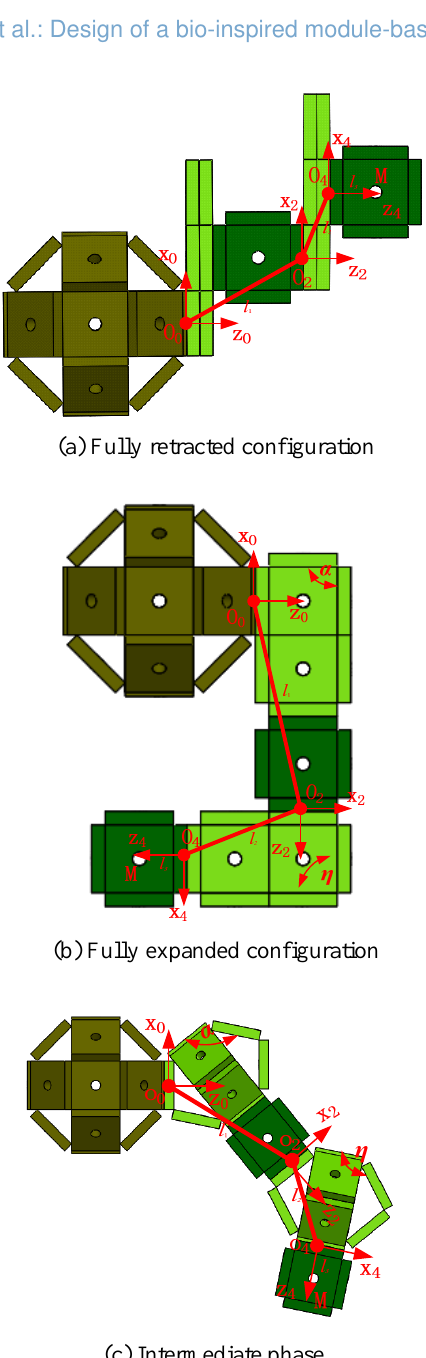
Based on the changes of the lengths of the three equivalent links l 1 , l 2 and l 3 , the workspace augmentation function of the two Sarrus-linkage-based muscles can be formulated and illustrated in Fig. 9.